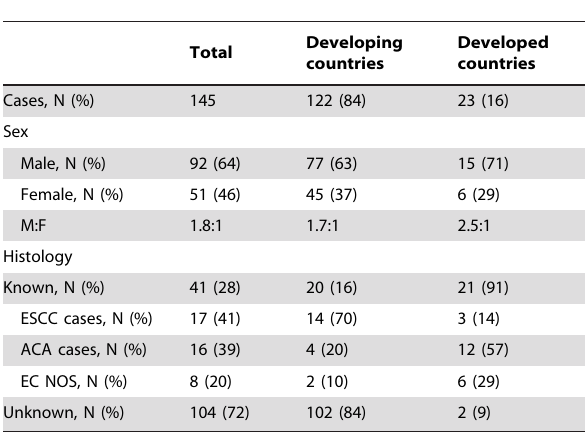
Table 5. Summary of age, sex and histologic data from published reports of esophageal cancer in young persons, overall and separately in developing and developed